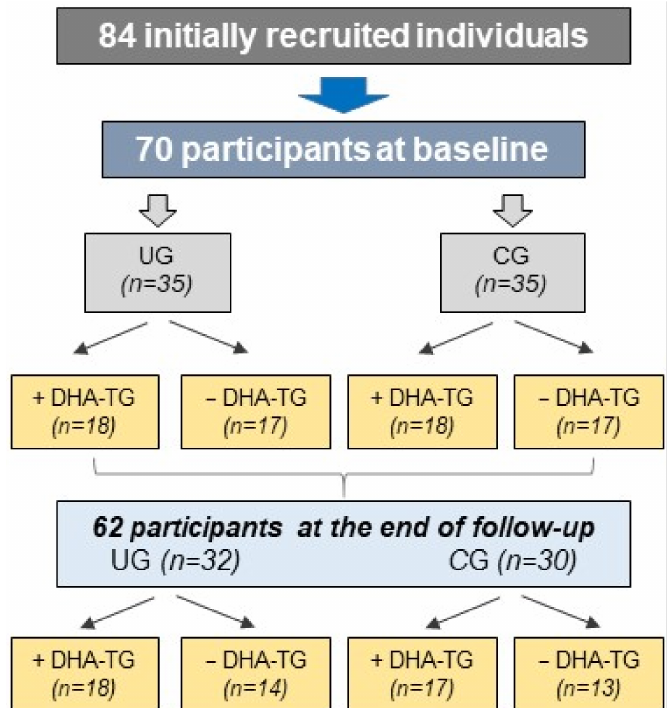
Figure 2. Flowchart of the study selection process and participants, at baseline and end of study. UG: uveitis group; CG: control group; +/ − DHA-TG: (with/without) triglyceride containing w-3 docosahexaenoic